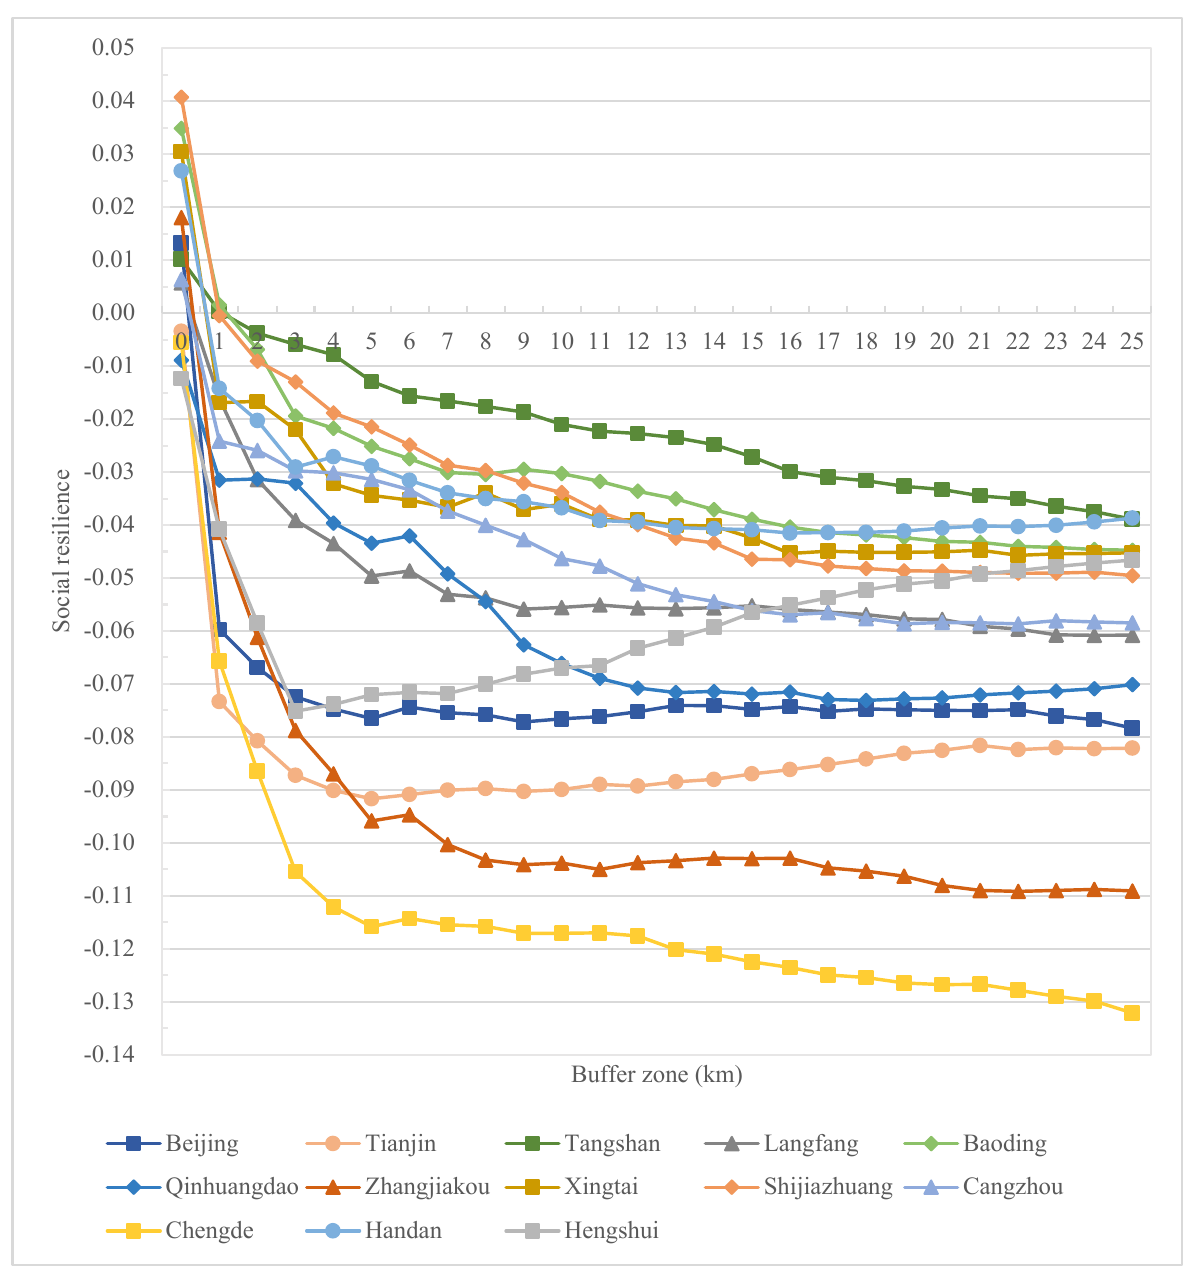
Figure 8. Social resilience changes along the urban–rural system at the city level in the BHTUA. Although the trend varies between cities and between resilience dimensions, the overall composite resilience of the study area still tends to be weakened from urban to rural. Still, the city and dimension-specific results can be used to give concrete resilience improvement strategies. In addition, results on the grid, county, prefectural city, and regional levels are all generated and visualized in this study to make urban plans at different